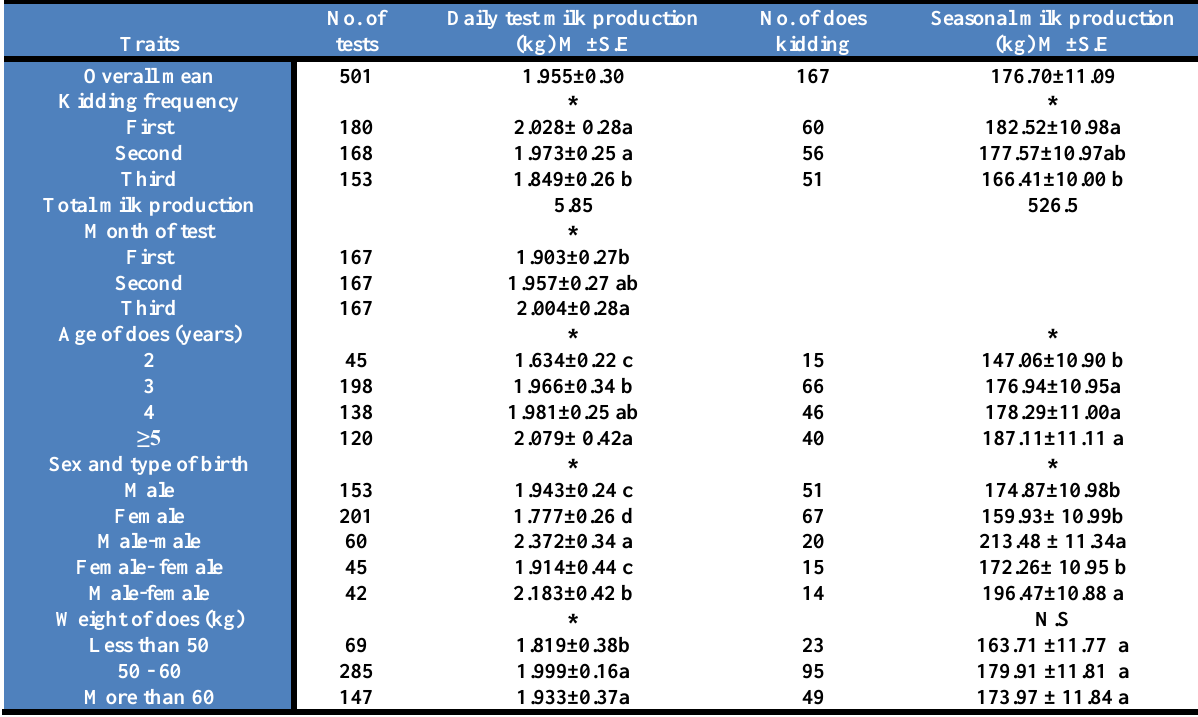
Table, 2: The factors affecting total milk Production (kg). Traits Overall